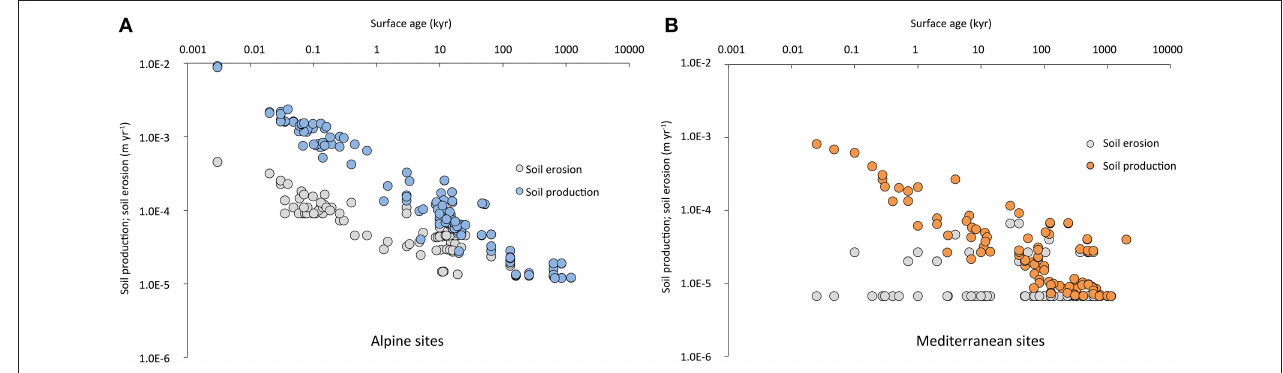
FIGURE 8 | Soil production rates (modeled) and erosion (or denudation) rates (measured or estimated) over time for the distinct geographic regions: (A) alpine and (B) Mediterranean